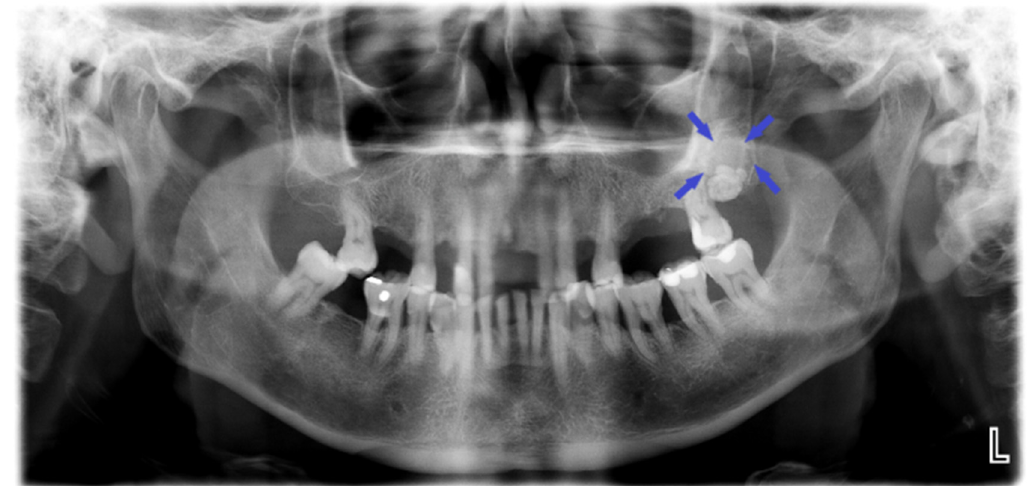
Figure 1. Panoramic radiograph.